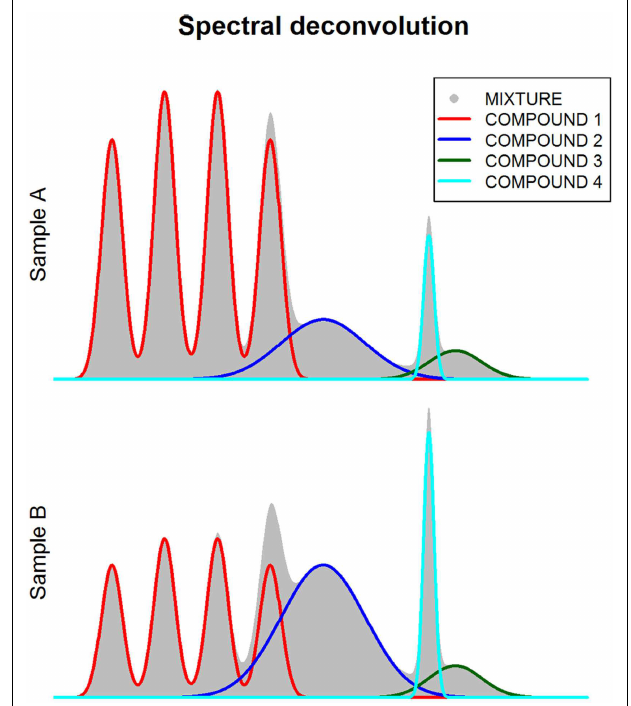
FIGURE 4 | Spectral deconvolution .This figure shows how spectra (gray shaded area) can be decomposed (i.e., deconvoluted) in multiple components corresponding to different metabolite